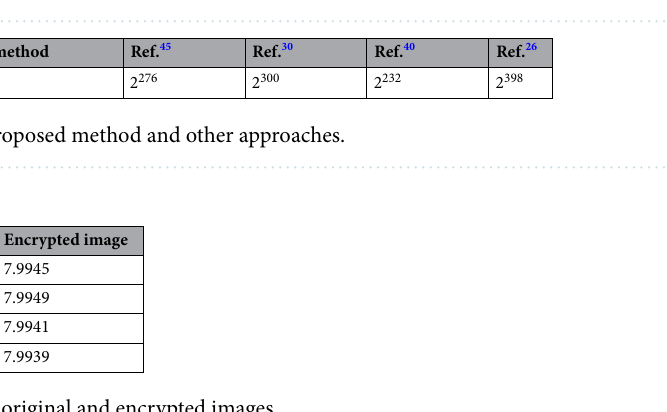
Table 6. The entropy of the original and encrypted